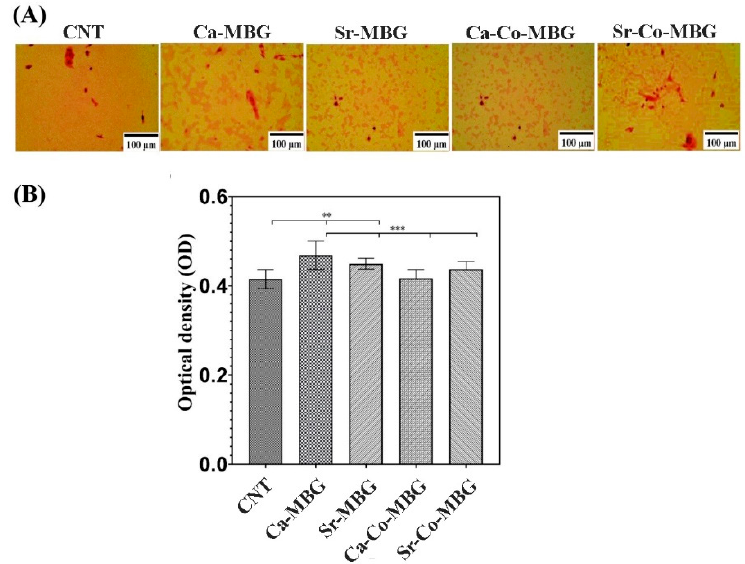
Figure 11. Results of the alizarin red staining assay. High-contrast microscope images ( A ), and quantification results ( B ).